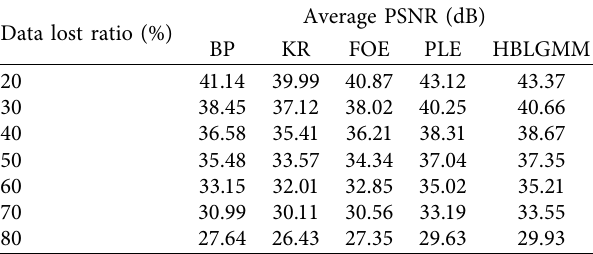
Table 6: Comparison of random filling